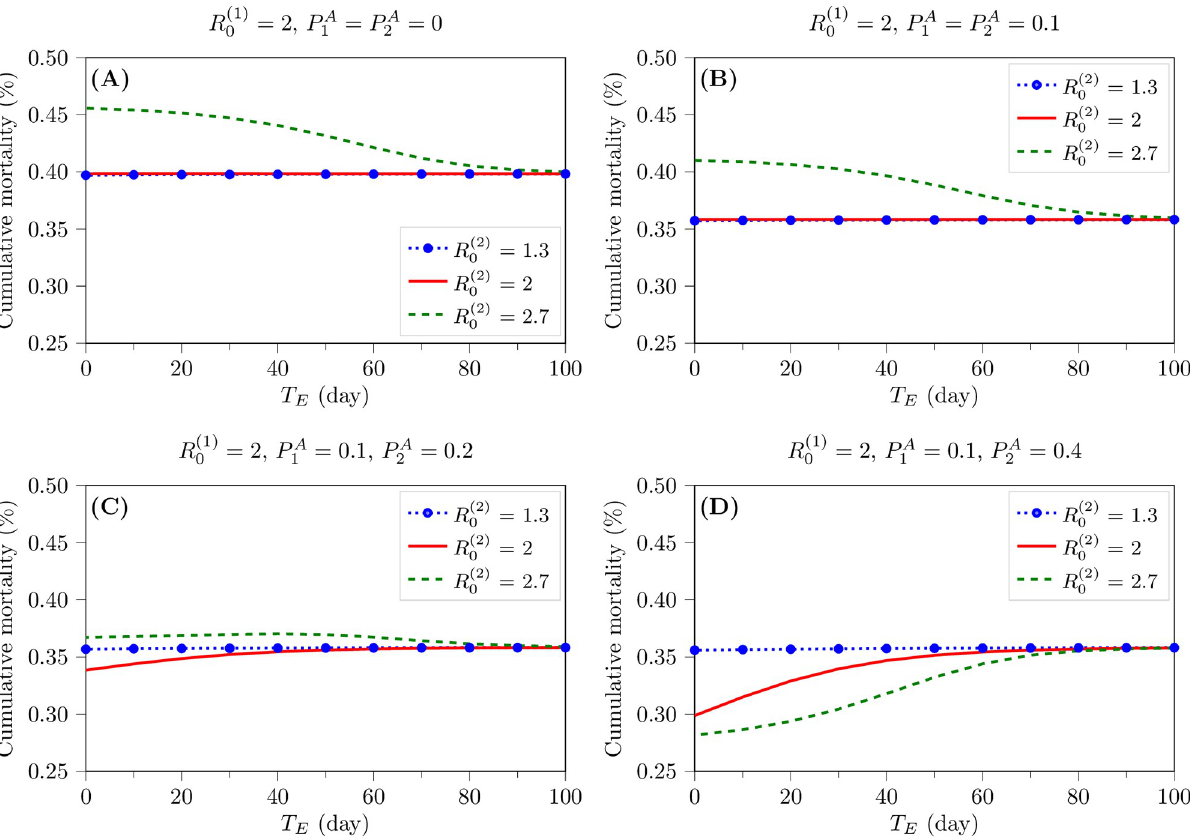
Fig 3. The effect of R ð 1 Þ , R ð 2 Þ , P A , P A , and T E on the cumulative mortality. These figures indicate that in the presence of asymptomatic transmission, 0 0 1 2 for the case of all- the emergence of a more-transmissible strain does not necessarily reflect more disease severity. A) The cumulative mortality vs. T E = 1.3, 2, and 2.7). In this case, the cumulative symptomatic infections in the population for different levels of transmissibility of the new variant ( R ð 2 Þ 0 ¼ 2 and P A ¼ 0 : 1 , these figures show the effect of increase in the mortality is higher than the case of having asymptomatic infection. B-D) For R ð 1 Þ 0 1 fraction of asymptomatic cases of the emergent strain ( P A = 0.1 (B), 0.2 (C), and 0.4 (D)), on the cumulative mortality. The increase in the fraction of 2 asymptomatic cases can reduce the cumulative